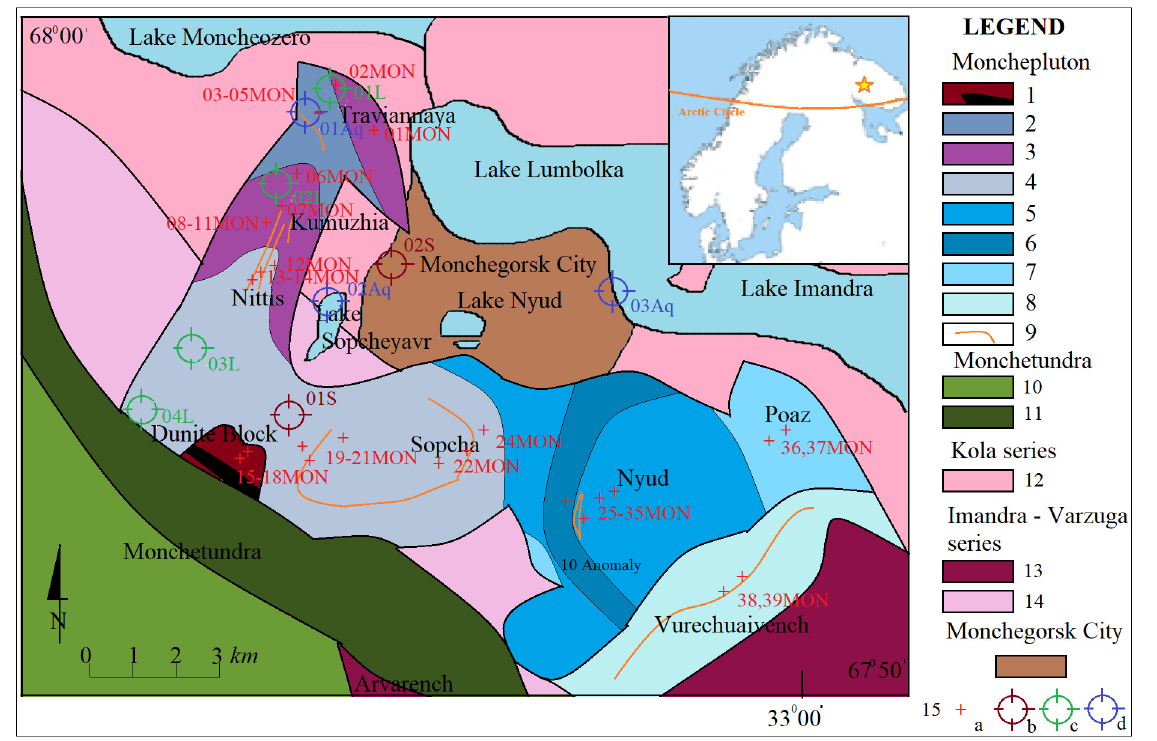
Figure 2. Geological Sketch of the Monchepluton intrusion (generalized, based on [3,4,23]). Abbre- viations: Monchepluton—1. Dunites and chromitites, 2. Harzburgites, 3. Other peridotites, 4. Ortho- pyroxenites, 5. Olivine norites, 6. Gabbro-norites, 7. Gabbro, 8. Gabbro–anorthosites, 9. Massive sul- fide mineralization; Monchetundra—11. Gabbro-anorthosites, and 12. Peridotites; Kola series—12. Archean gneisses; Imandra Varzuga series—13. Hypersthene diorites, 14. Metasediments, and